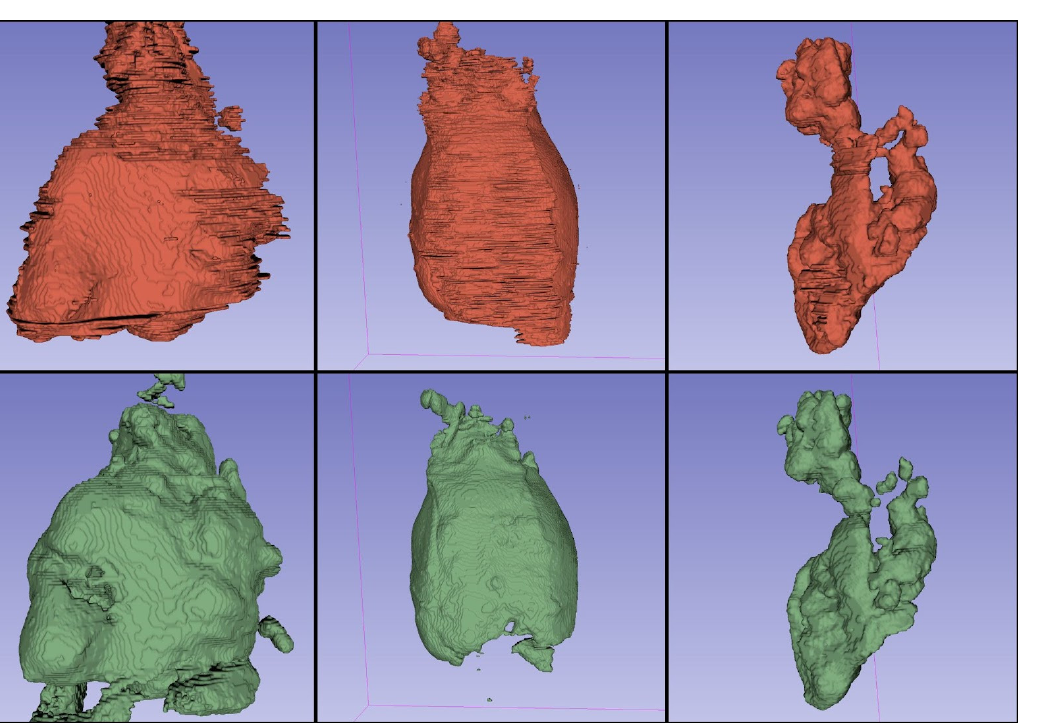
Figure 2. Three-dimensional renderings of the segmentations performed by a human reader (red) and from the best performing nnU-Net model (green). Smooth edge segmentation can be noted in the segmentations performed by the nnU-Net when compared to the human